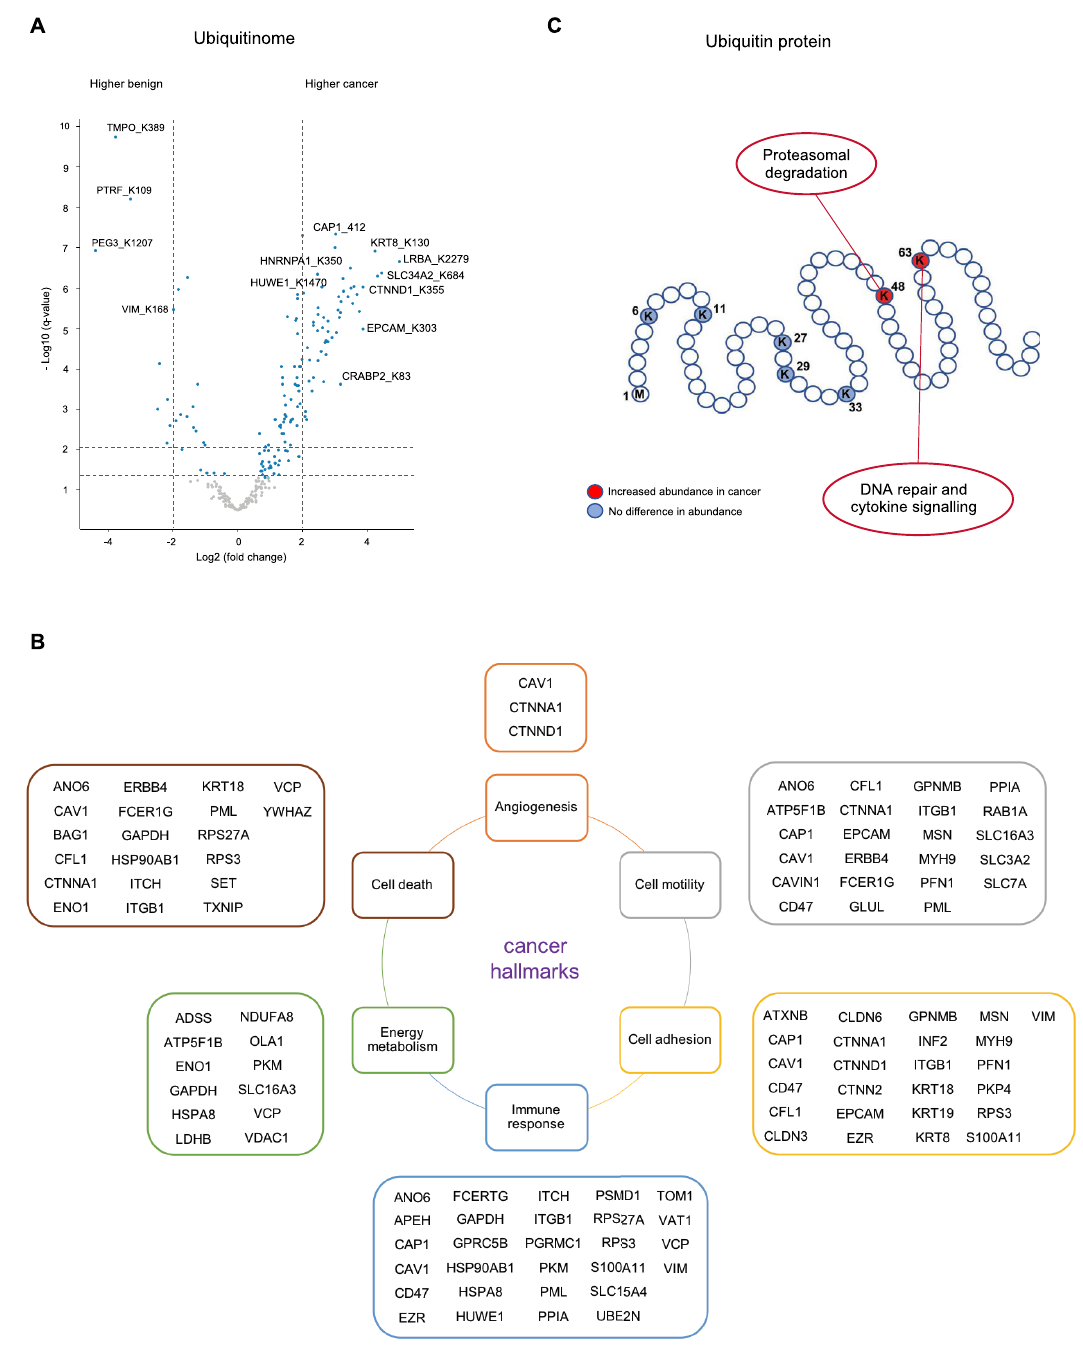
Figure 2. Ubiquitination is involved in the regulation of cancer hallmarks. (A) Volcano plot of the pairwise comparison between high-grade serous cancer (HGSC) and benign ovarian tissue ubiquitinomes. Marked in blue are the significantly regulated ubiquitinated sites (q-value < 0.05). These correspond to a total of 151 ubiquitinated sites and 116 proteins. Highlighted are proteins known to be associated with ovarian cancer pathogenesis. (B) Cancer hallmarks found regulated by ubiquitination in HGSC and benign tissues. Differentially expressed proteins (q-value < 0.05) belonging to each of the cancer hallmarks are annotated. (C) Overview of the ubiquitin lysine (K)-linkage sites identified in our study. Marked in red are the ubiquitinated lysines (K48 and K63) found to be more abundant in HGSC compared to benign